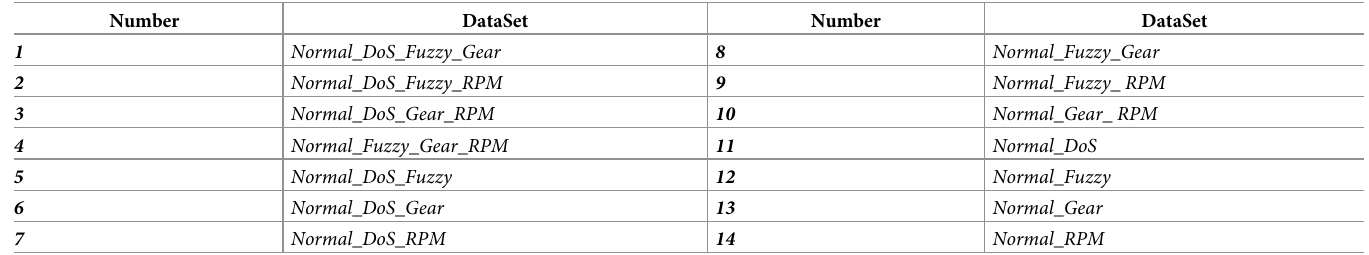
divided into three categories: (1) three types of attacks; (2) two types of attacks; and (3) a single type of attack. The datasets were numbered sequentially as shown in Table 3. The above 14 combinations of different attacks were tested respectively using the models with the threshold value of 0.5, and the resultant evaluation indexes of each model in the 14 data sets were compared in the form of boxplot. The results of the 11-bit and 29-bit CAN ID tests are shown in Figs 10 and 11. The dotted lines on these figures are the mean value of each boxplot. We can see from these figures that the Mosaic coding method could not only achieve better results in all the indexes compared with the direct sequential coding method, it also showed a lower variation for different attack combinations. This means our model is more sta- ble and reliable for different combinations of attacks with higher detecting accuracy, which is better in dealing with real-world attacks. Analyzing the above boxplot and our specific result data, we also found that no matter whether the 11-bit or the 29-bit CAN IDs were used, the combinations of attacks numbered 5 ( Normal_DoS_Fuzzy ) and 12 ( Normal_Fuzzy ) performed the worst over all evaluation indexes under different coding methods. However, when the combination numbered 13 ( Normal_- Gear ) was used, the overall performance was relatively good. Nevertheless, whenever the Fuzzy attack was not included in the test combination, the results achieved by direct sequential cod- ing method were not so bad, but they could always be further improved by our Mosaic coding method. If the test combination contained Fuzzy attack, the direct sequential coding method performed relatively poor, but the Mosaic coding method could always make some obvious improvements. In short, the Mosaic and centralized Mosaic coding methods always performed Table 3. Data set combinations and their